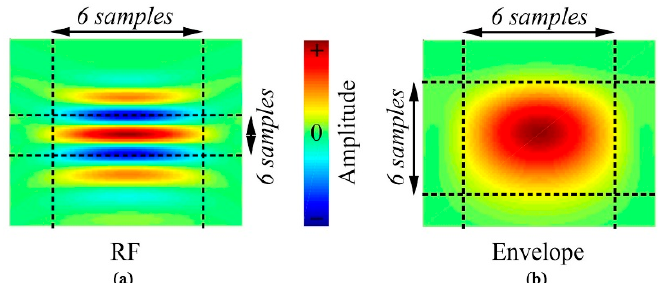
Figure 1. Representation of the system’s point-spread-function (PSF) visualized using radio frequency (RF) ( a ) and envelope ( b ) data. The data sampling points required to capture a circular-shaped peak in the cross-correlation function are indicated in the figure. Please note that the envelope data sampling grid is a downsampled version of the RF data sampling grid.